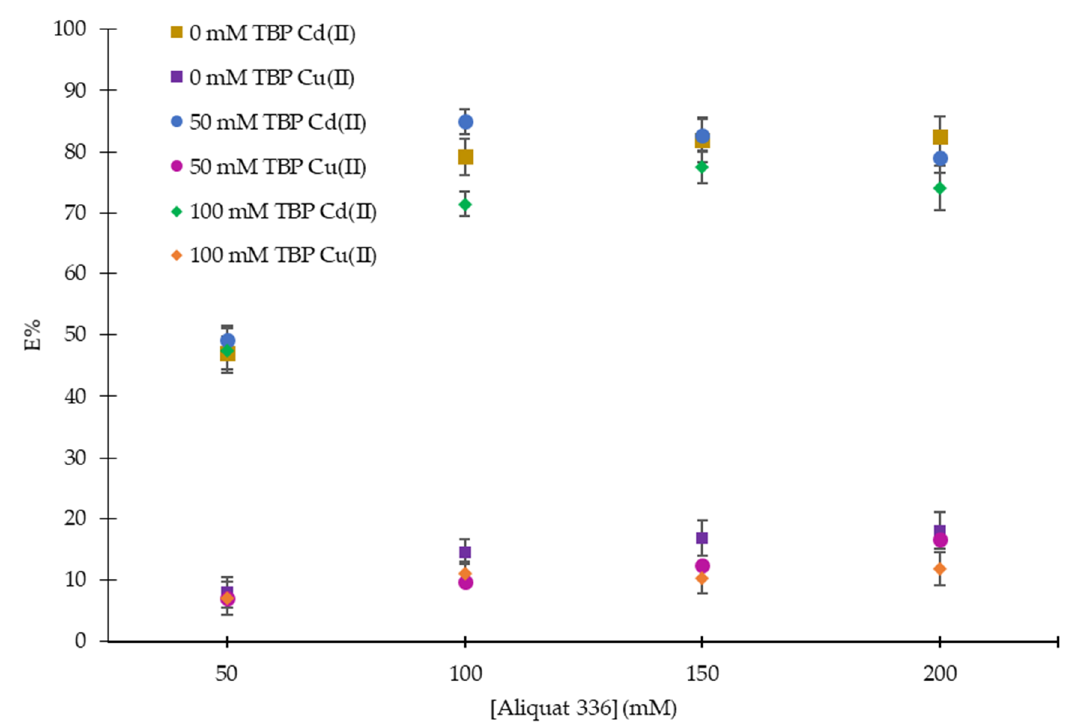
Figure 2. Effect of Aliquat 336 concentration on the extraction of Cd(II) and Cu(II) ions (mixing time: 10 min; operating temperature: 28 ± 1 °C; mixing speed: 150 rpm; Na 2 SO 4 : 200 mM; diluent: toluene; / L; pH = M i : 100 mg/L; pH eq : 5; O:A ratio = 1:1). M eq : 5; O:A ratio i : 100 mg